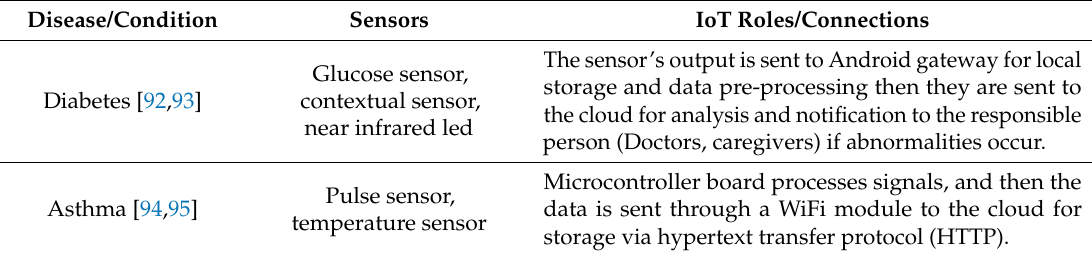
Table 7. Type of sensors that are usually used in specific disease and detailed data transmission descriptions. Disease/Condition The sensor’s output is sent to Android gateway for local storage and data pre-processing then they are sent to the cloud for analysis and notification to the responsible person (Doctors, caregivers) if abnormalities occur. Microcontroller board processes signals, and then the data is sent through a WiFi module to the cloud for storage via hypertext transfer protocol